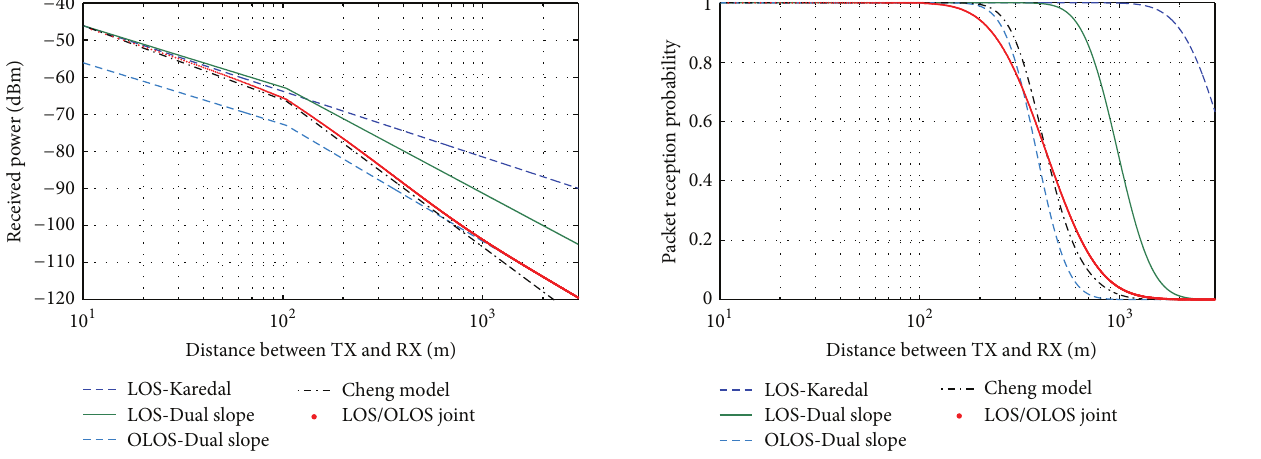
Figure 9: Received power as a function of distance. Breakpoint distance of 𝑑 𝑏 = 104 m is used for the LOS-Dual slope, OLOS-Dual slope, Cheng, and joint LOS/OLOS models.